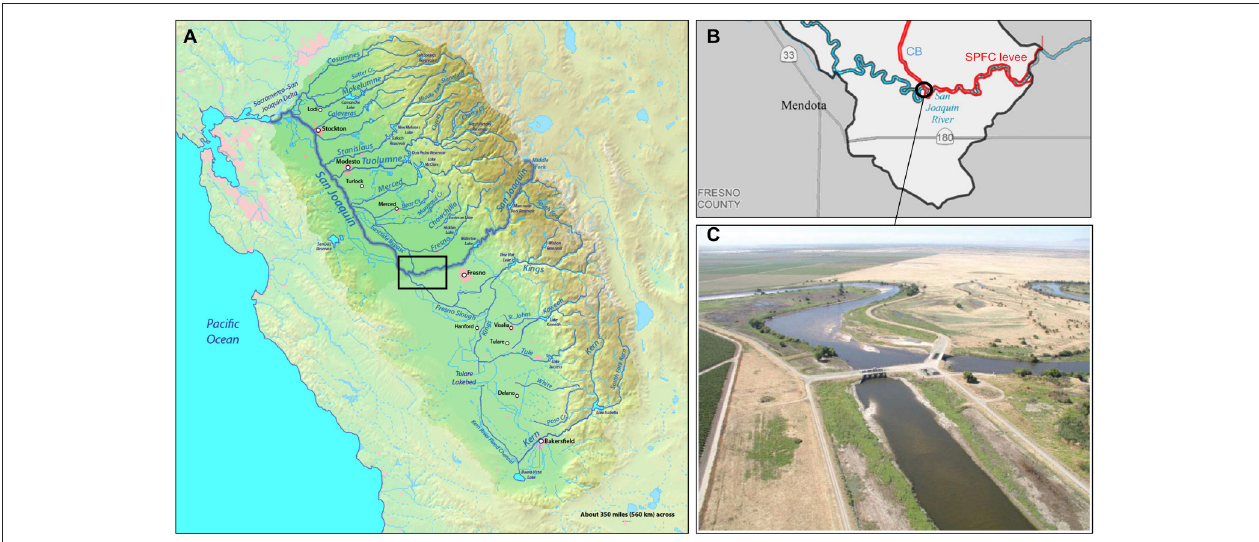
FIGURE 1 | (A) Map of the California Central Valley showing the San Joaquin River as a thick blue line. The area of the SAR demonstration site is depicted by the black rectangle. (B) Zoom-in of the region (rectangle in A ) showing the San Joaquin River, the levees and the Chowchilla Canal Bypass (CB). (C) Photograph of the confluence of the Chowchilla Bypass and the San Joaquin River with adjacent farmland (Source: SJR FCPA).